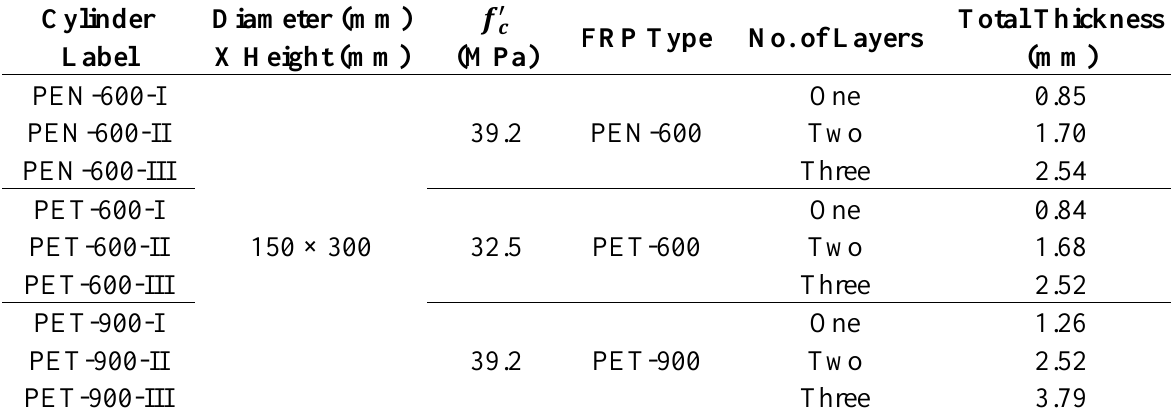
Table 1. Summary of cylinders variables (Modified from Dai et al. [13], copyright 2011